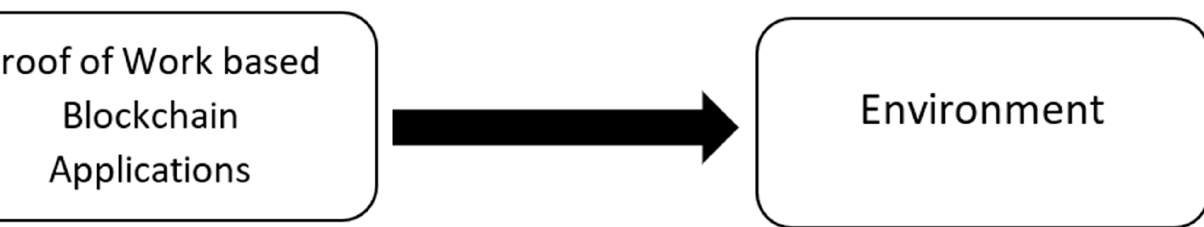
Figure 1. Relationship Under